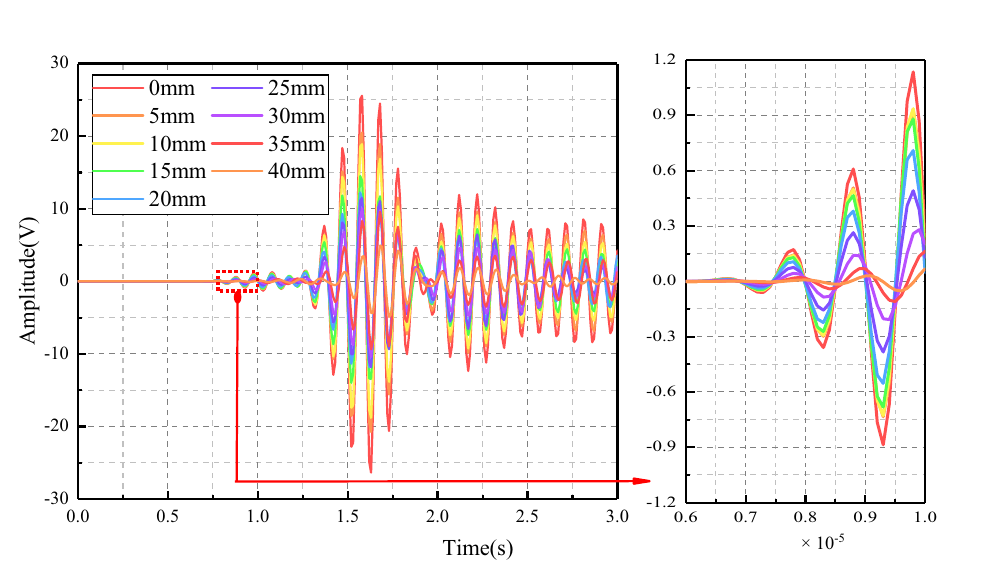
Figure 12. Time domain signal diagram received by PZT sensor (100